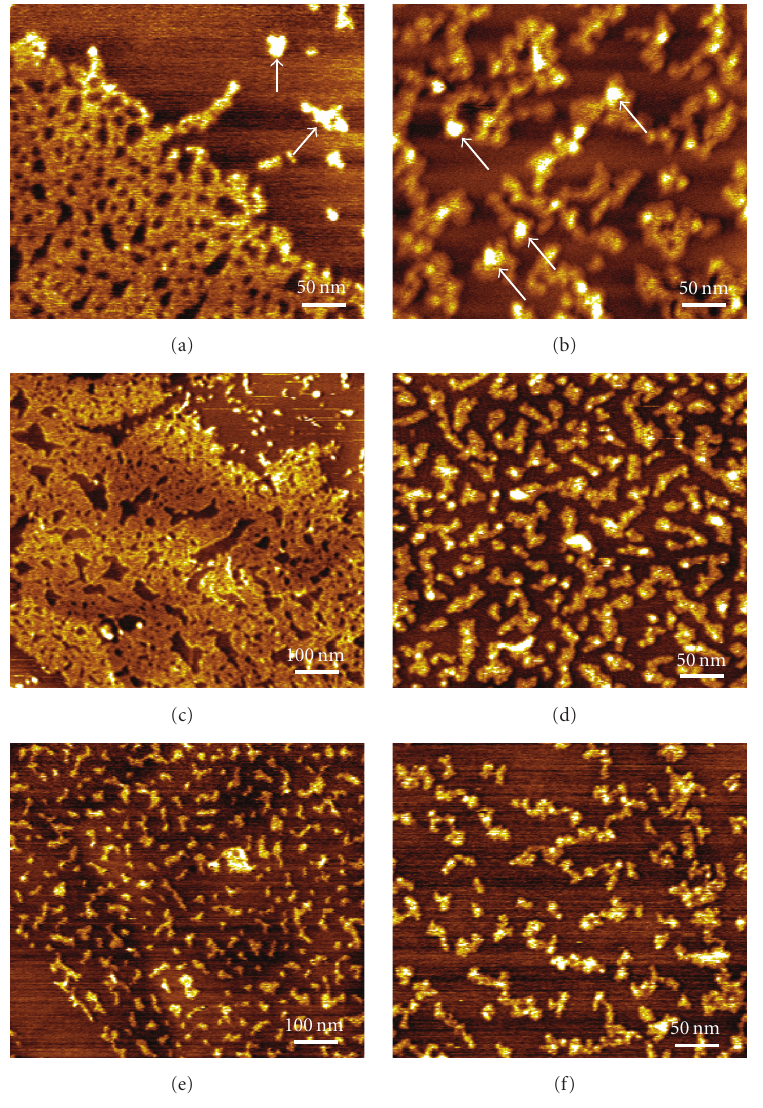
Figure 2: AFM topographical images in air of eTBA molecules, immobilized onto HOPG by spontaneous adsorption during 3 minutes, from solutions of 1 μ gmL − 1 eTBA in pH 7.0 0.1 M phosphate bu ff er: (a, b) in the absence and (c–f) in the presence of (c, d) 100 mM and (e, f) 200 mMK + , after (c, e) 1 hour and (d, f) 24 hours of